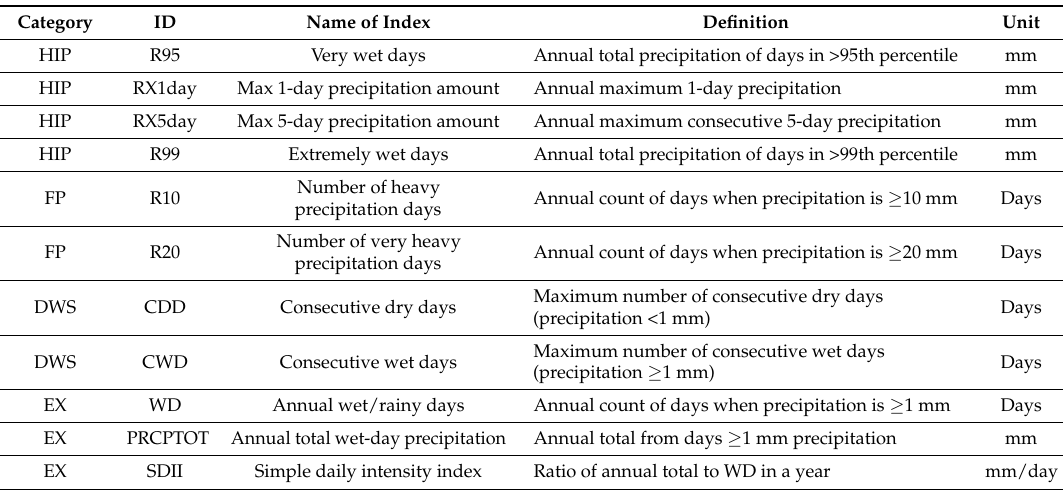
Table 2. The description of ETCCDMI (Expert Team on Climate Change Detection, Monitoring and